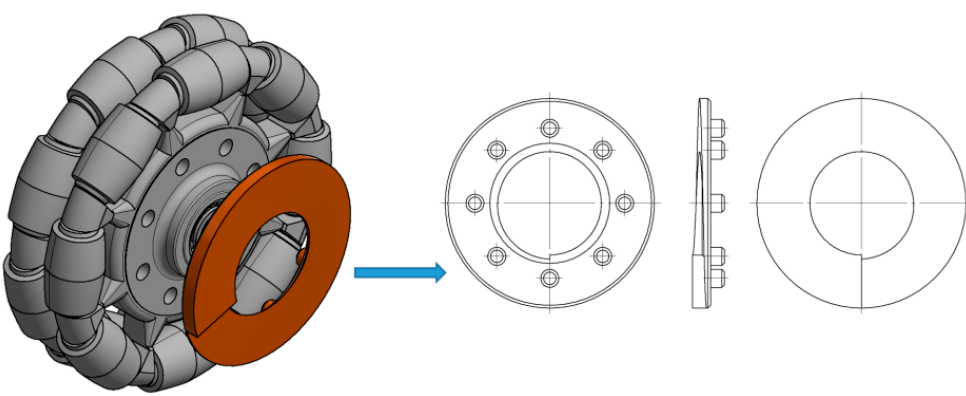
Figure 7. CAD model of omnidirectional wheel with measuring plate.